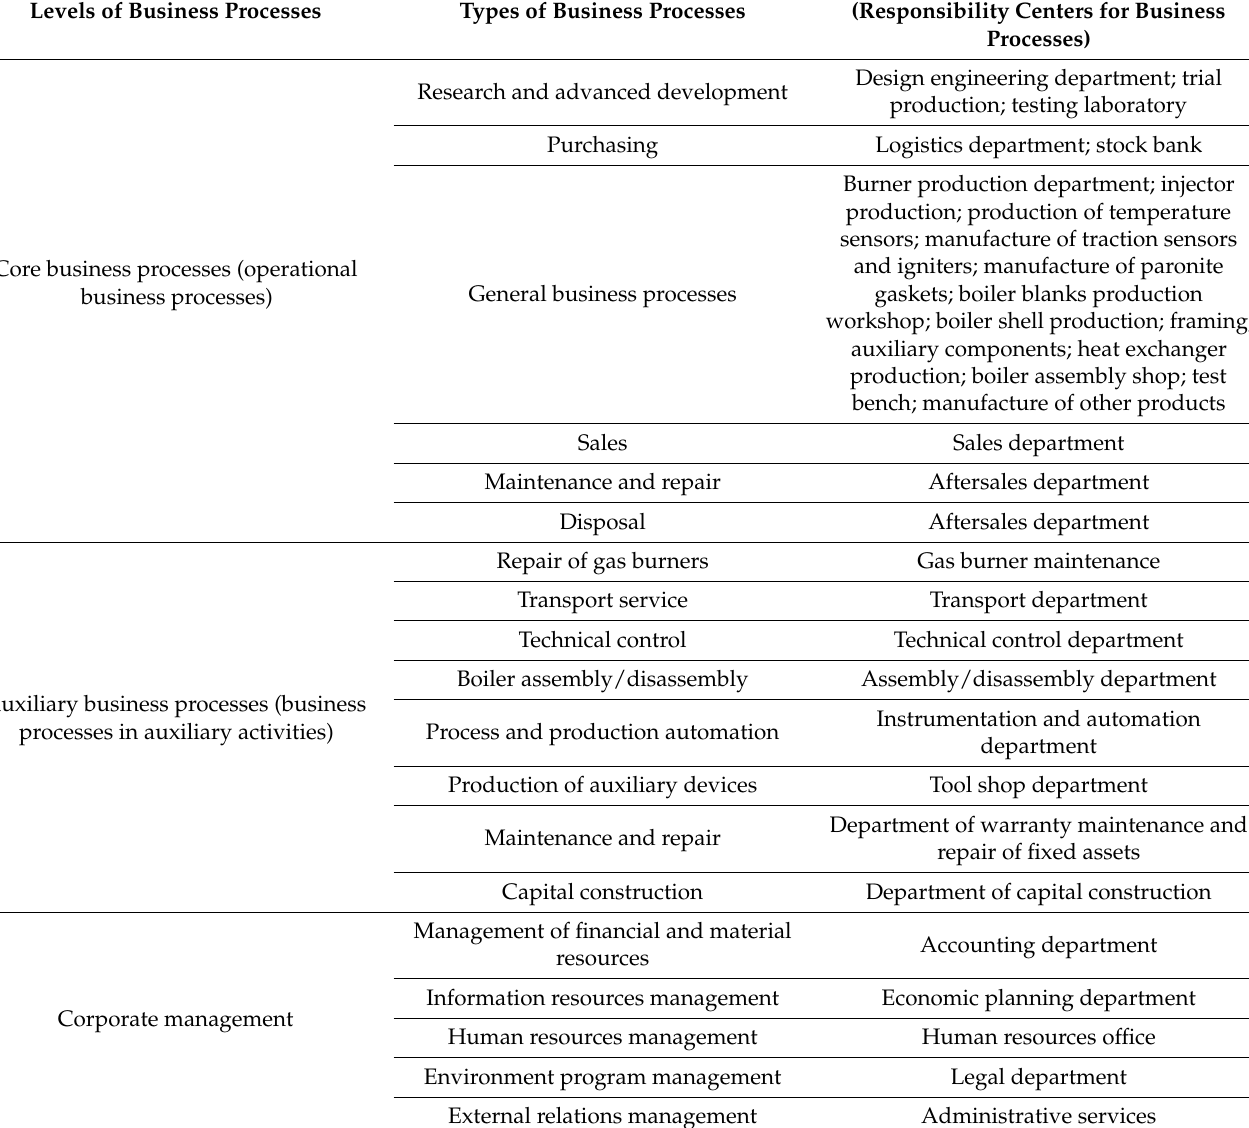
Table 2. Types of business processes in boiler